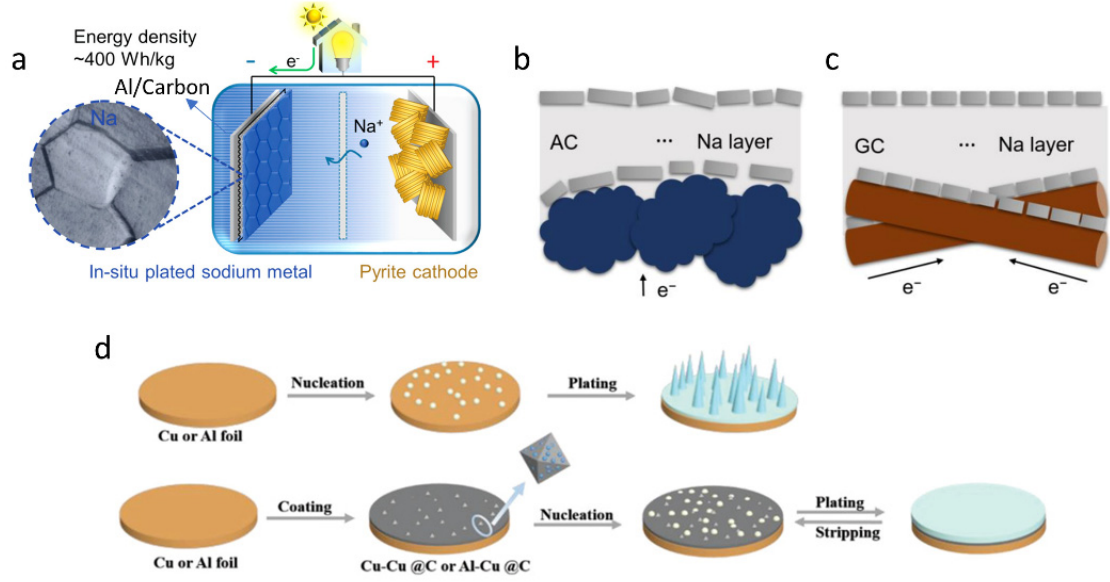
Figure 6. Schematic illustrations of the ( a ) anode − free cell compromising carbon-coated Al current collector loading with in situ plated Na metal as the anode and Pyrite cathode [64]; copyright 2017 American Chemical Society. The Na deposition on ( b ) amorphous carbon (AC) and ( c ) graphitic carbon (GC): the grey strips stand for the deposited sodium on the carbon, where uneven and large cracks of Na layers formed on the AC, whereas uniform, small cracks of Na layer formed on the GC [23]; with permission from Springer Nature, copyright 2022. ( d ) Na deposition on bare Cu or Al foils and MOF − derived copper-carbon (Cu@C) composite [65]. Reproduced with the permission of ref. [66], copyright 2022 Wiley − VCH Verlag GmbH & Co. KGaA, Weinheim.